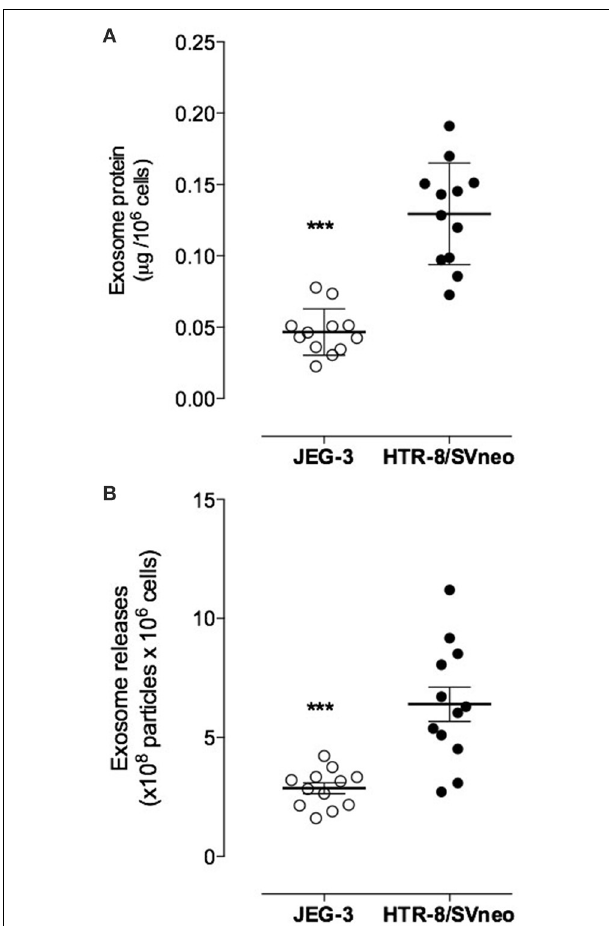
FIGURE 3 | Exosome releases from EVT cell lines. Exosomal protein and number of exosomes were quantified cell conditioned media from JEG-3 and HTR-8/SVneo cells using a colorimetric assay and ELISA kit, respectively. (A) exosomes concentration presented as μ g exosomal protein per 10 6 cells and (B) Number of exosomes particles. Data are presented as scatter dot plot and values are mean ± s.e.m. In (A,B) ∗∗∗ p < 0 . 001 vs.